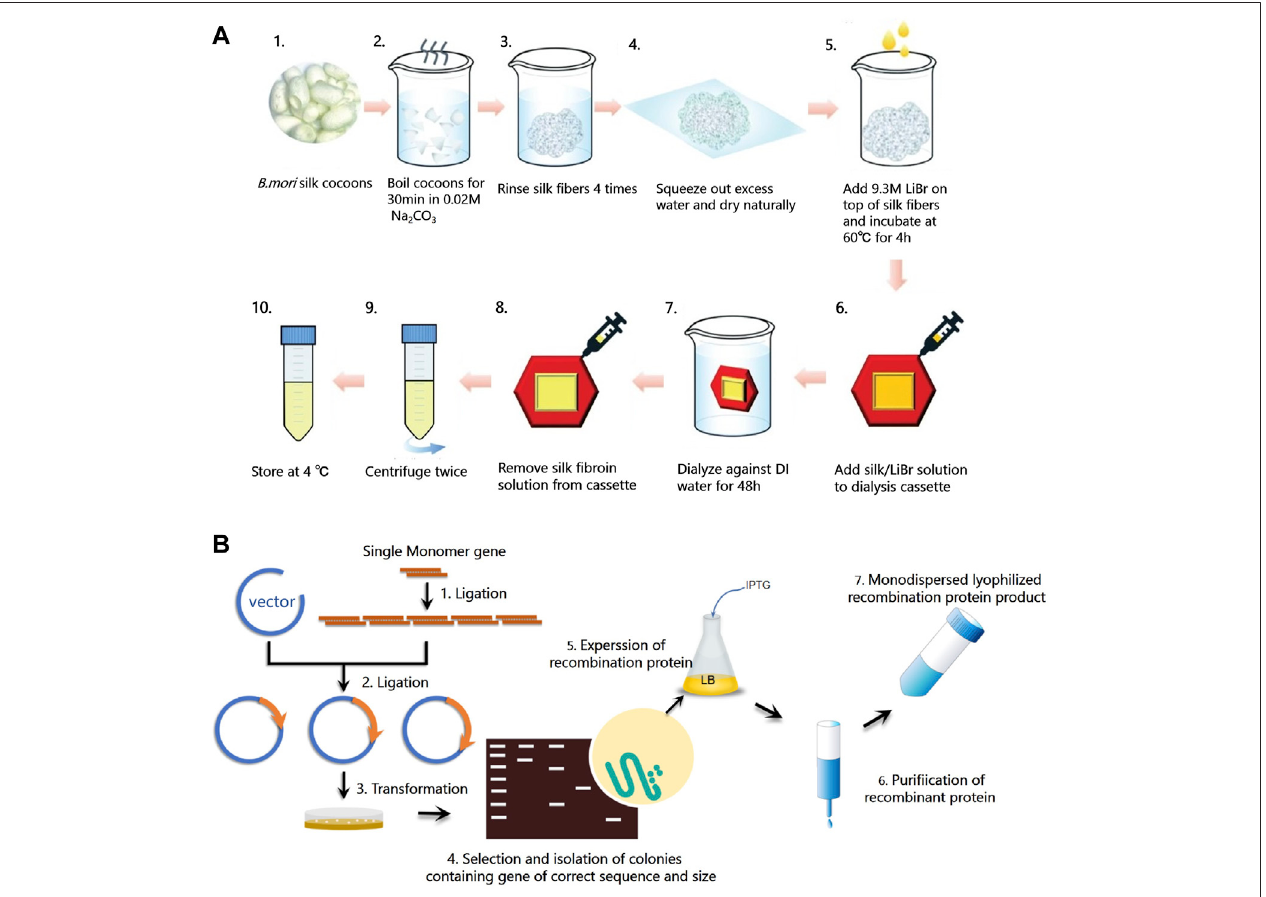
FIGURE3| Synthesismethodsofsilks. (A) Schematicdiagramofsilk fi broinextractionprocedure.Silk fi broin(SF)canbeextractedfromnative B.mori silkfollowing a three-step process: fi ber degumming (step A1-4), fi ber dissolution (step A5), and solution puri fi cation (step A6-10). Degummed silk fi ber and regenerated silk fi broin solutioncanbeobtainedfromthisprocedure.Adapted withpermissionfromref(Malinowskietal.,2019).Copyright2019SpringerNature. (B) Schematicdiagramofthe synthesis procedure of recombinant silks, including plasmid construction (step B1-2), host transformation (step B3-4), protein expression (step B5), and puri fi cation (step